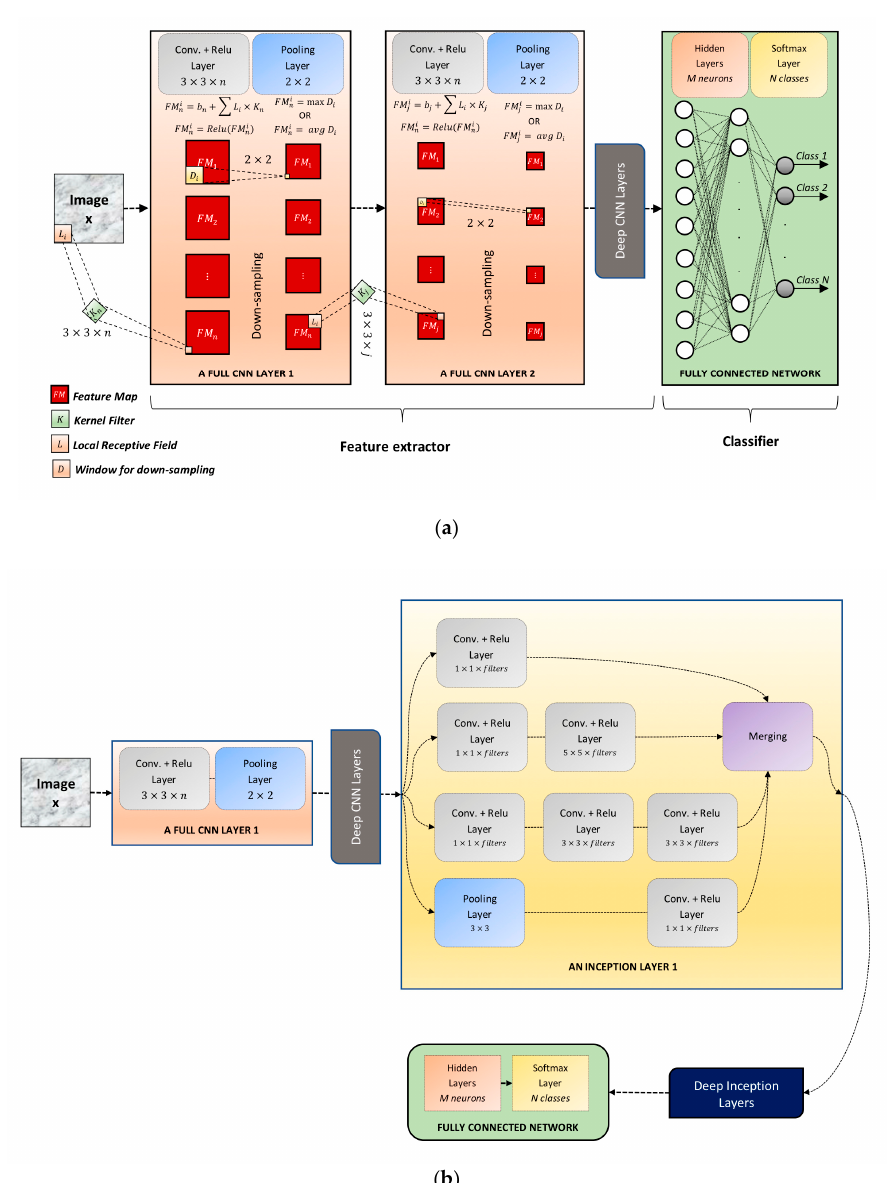
Figure 1. Convolutional neural network (CNN) architectures. ( a ) Fundamental components of CNN and ( b ) Inception